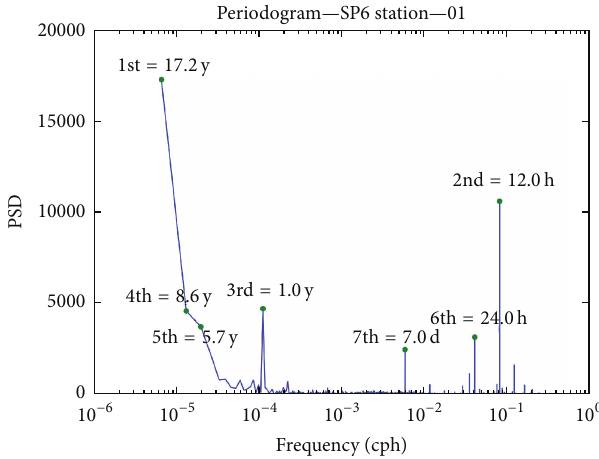
Figure 3: Periodogram for SP6 station hourly average time series. The 7 peaks with highest spectral density represent the periods: 17.2 years, 12 hours, 1 year, 8.6 years, 5.7 years, 24 hours, and 7 days. The frequency unit is cycles per hour (CPH) and PSD is the power spectrum